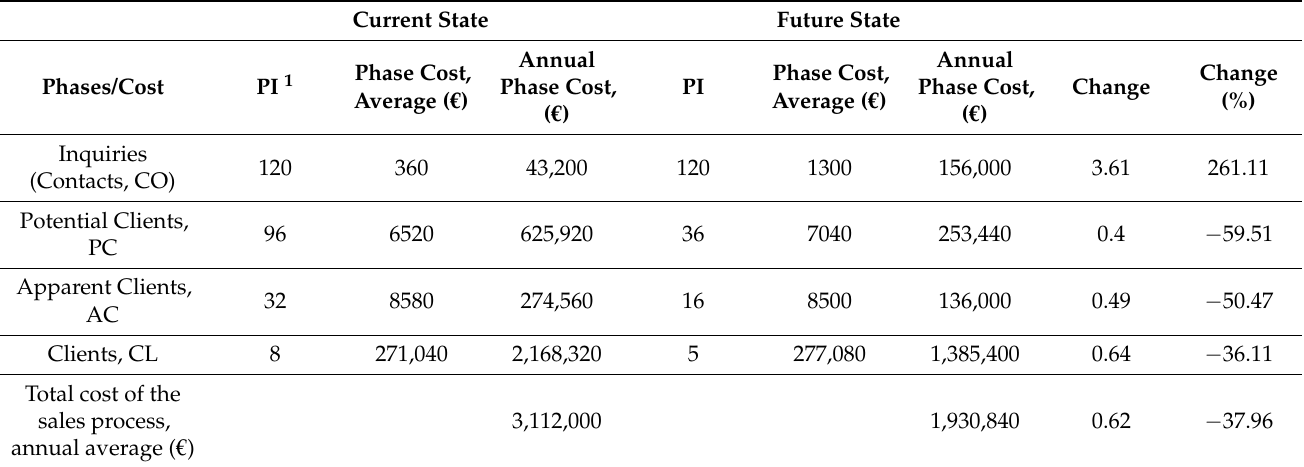
Table 6. Key performance indicator—average annual sales process